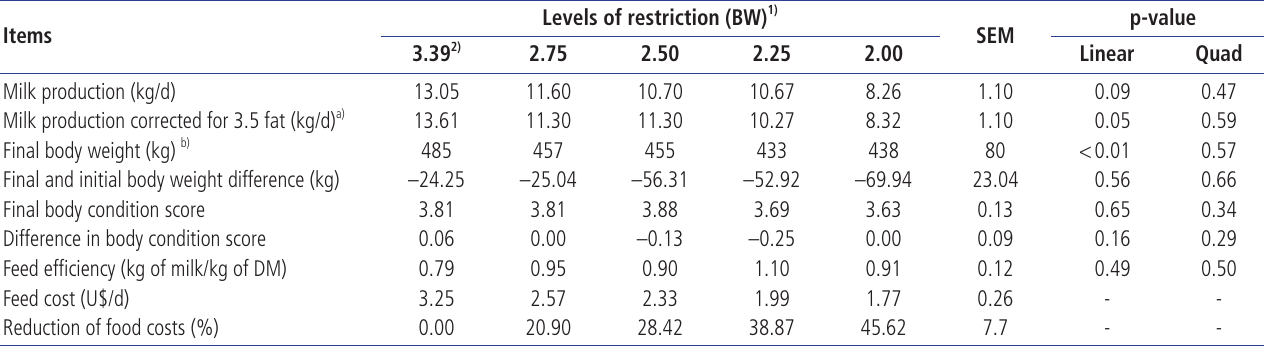
Table 6. Performance and feed efficiency in F1 Holstein/Zebu cows under quantitative feed restriction in the middle third of lactation